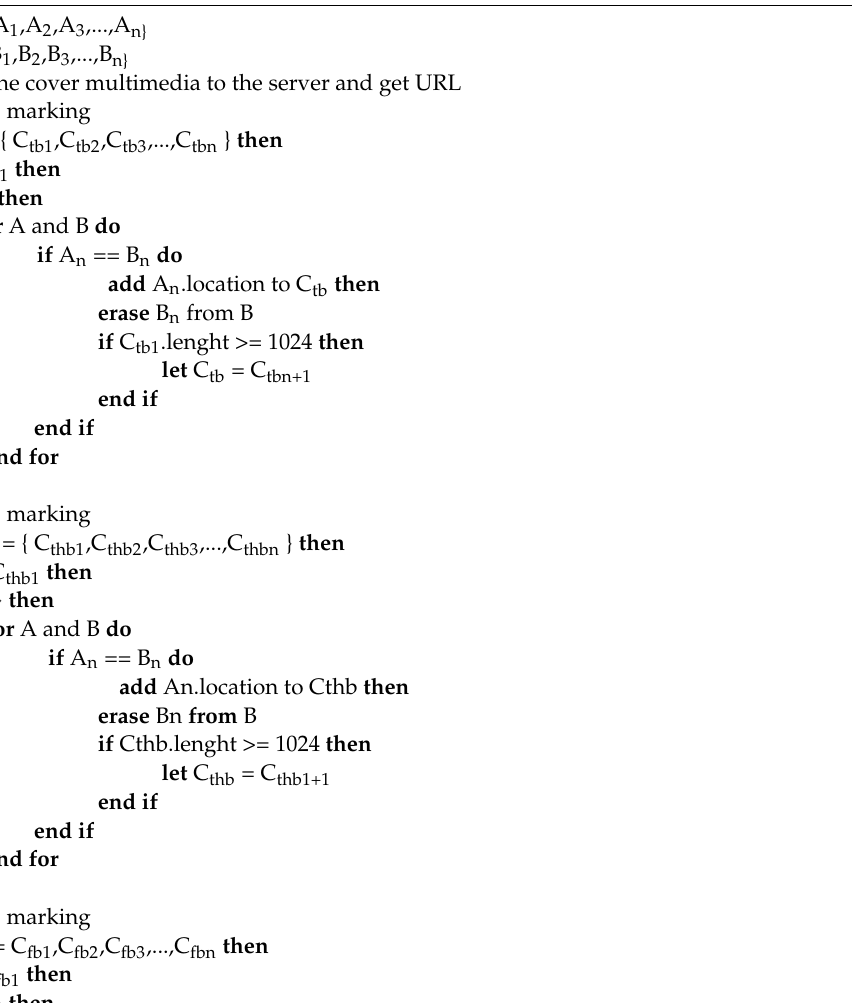
Algorithm 1. OTA-Steganography